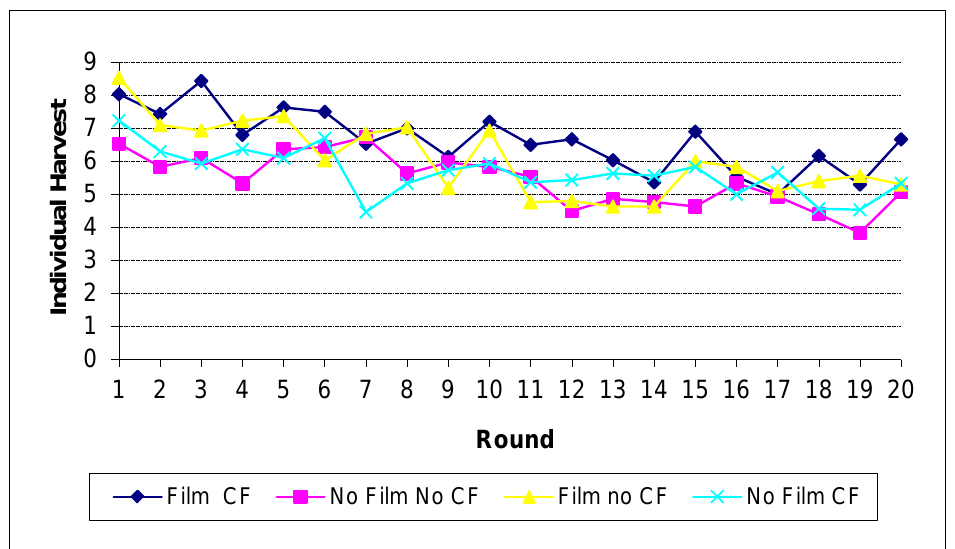
Figure 1. Comparing average individual harvests per round per